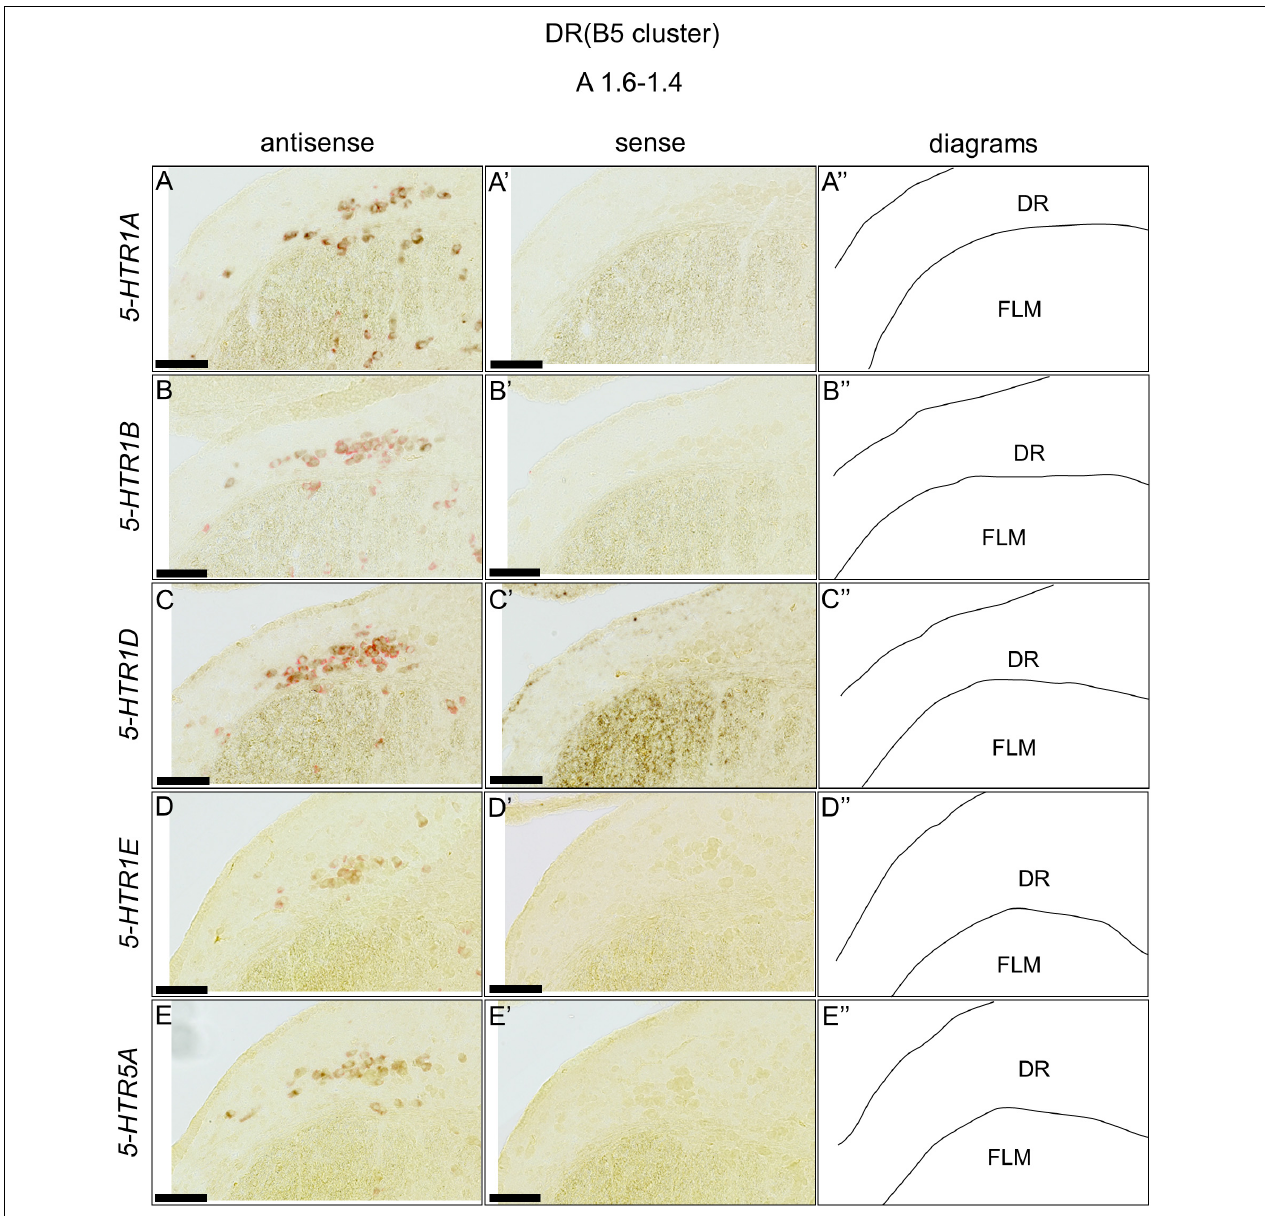
FIGURE 8 | Double in situ hybridization of 5-HTRs and TPH2 in the DR (B5) of the P1 chick brainstems. Digoxigenin-labeled ( 5-HTRs ) and fluorescein-labeled TPH2 RNA antisense (A–E) and sense (A’–E’) probes were used for double in situ hybridization in coronal sections of P1 chick brains. (A”–E”) Diagrams of coronal sections are shown in the rightmost panels. DR, dorsal raphe; FLM, fasciculus longitudinalis medialis; P1, post-hatch day 1. Scale bars = 100 µ